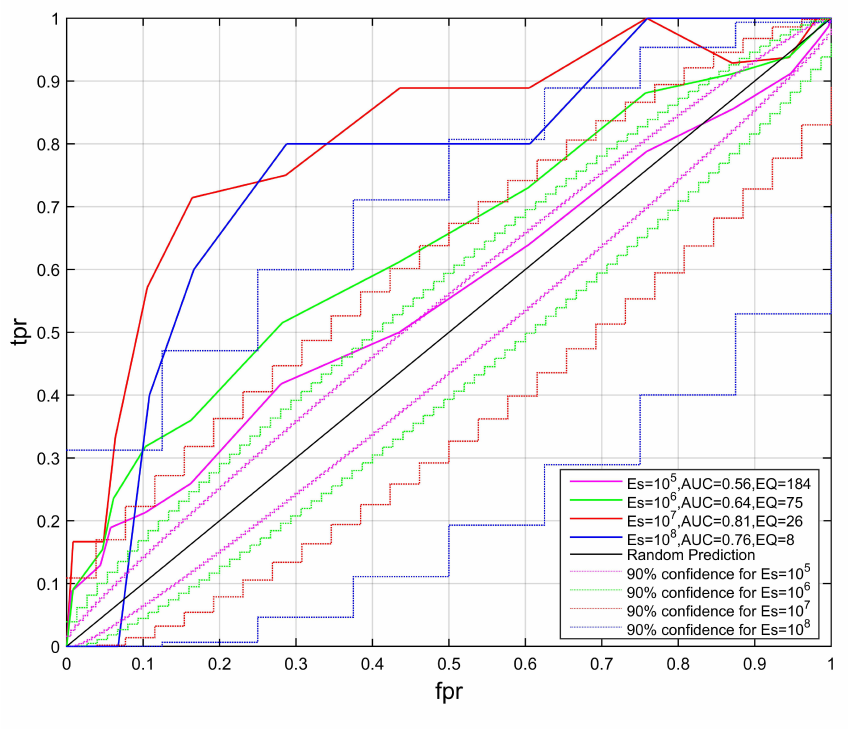
Figure 9. ROC prediction of earthquake events selected according to different E s